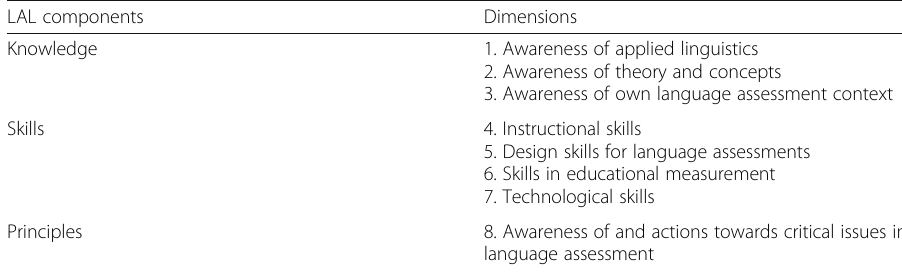
Table 1 Eight dimensions of LAL for language teachers LAL